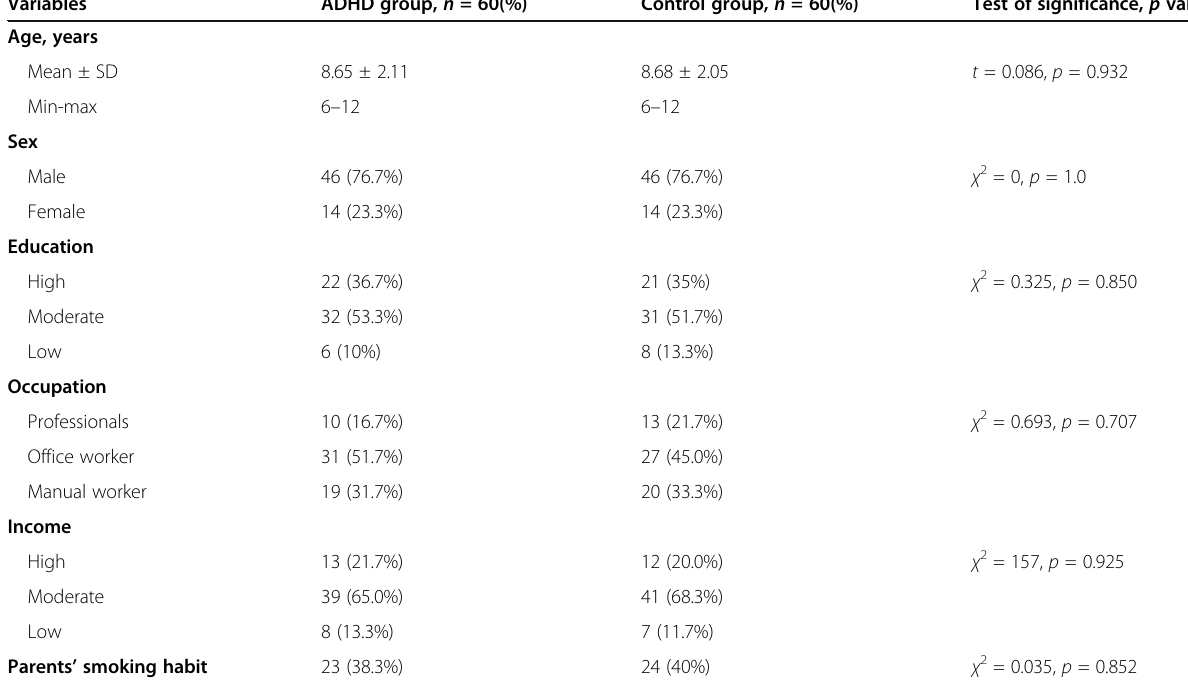
Table 1 Sociodemographic data of the ADHD and control groups